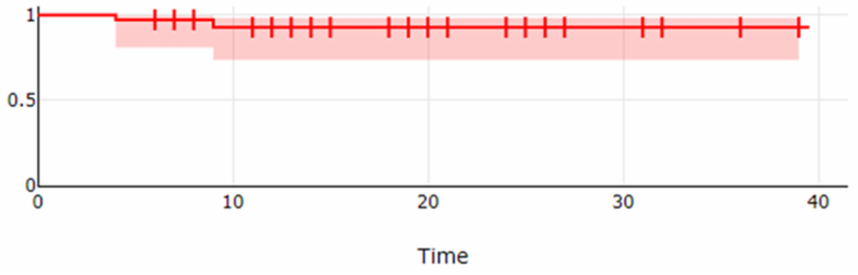
Figure 1. The actuarial 3-year local control of patients affected by POF and treated by IRT. Three local recurrences were observed, including two marginal (one nasal vestibule and one lip) and one central recurrence (nasal vestibule). No lymph node recurrences were recorded. In all cases of recurrence, salvage surgery was